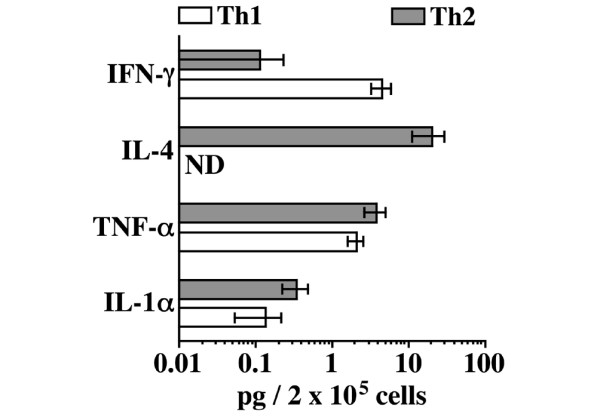
Cytokine content in the membranes of activated Th1 and Th2 cell clones. Cytokine levels were determined by enzyme-linked immunosorbent assay in Th cell membranes. Th cells were activated by CD3 cross-linking for six hours before membrane preparation. The bars represent the mean ± standard deviation of six Th1 and six Th2 cell clones, and indicate the cytokine levels in the cell membranes from 2 × 105 cells. When a given cytokine was not detectable, it was assigned the value 0 for mean determination. *P < 0.05. IFN, interferon; IL, interleukin; ND, not detectable; Th, T-helper; TNF, tumour necrosis factor.